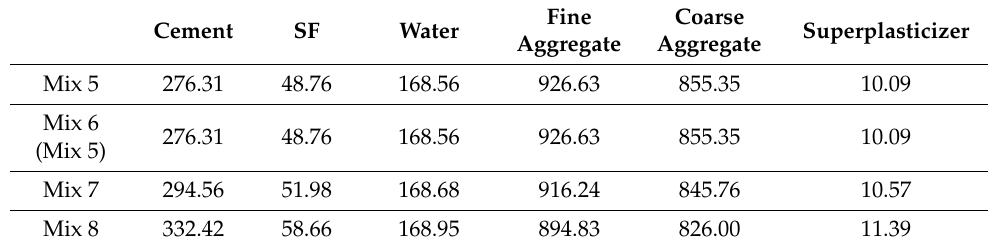
Table 8. Optimal design mixtures for Case 2: low-CO 2 concrete with carbonation (unit: kg/m 3 ). Cement SF Water